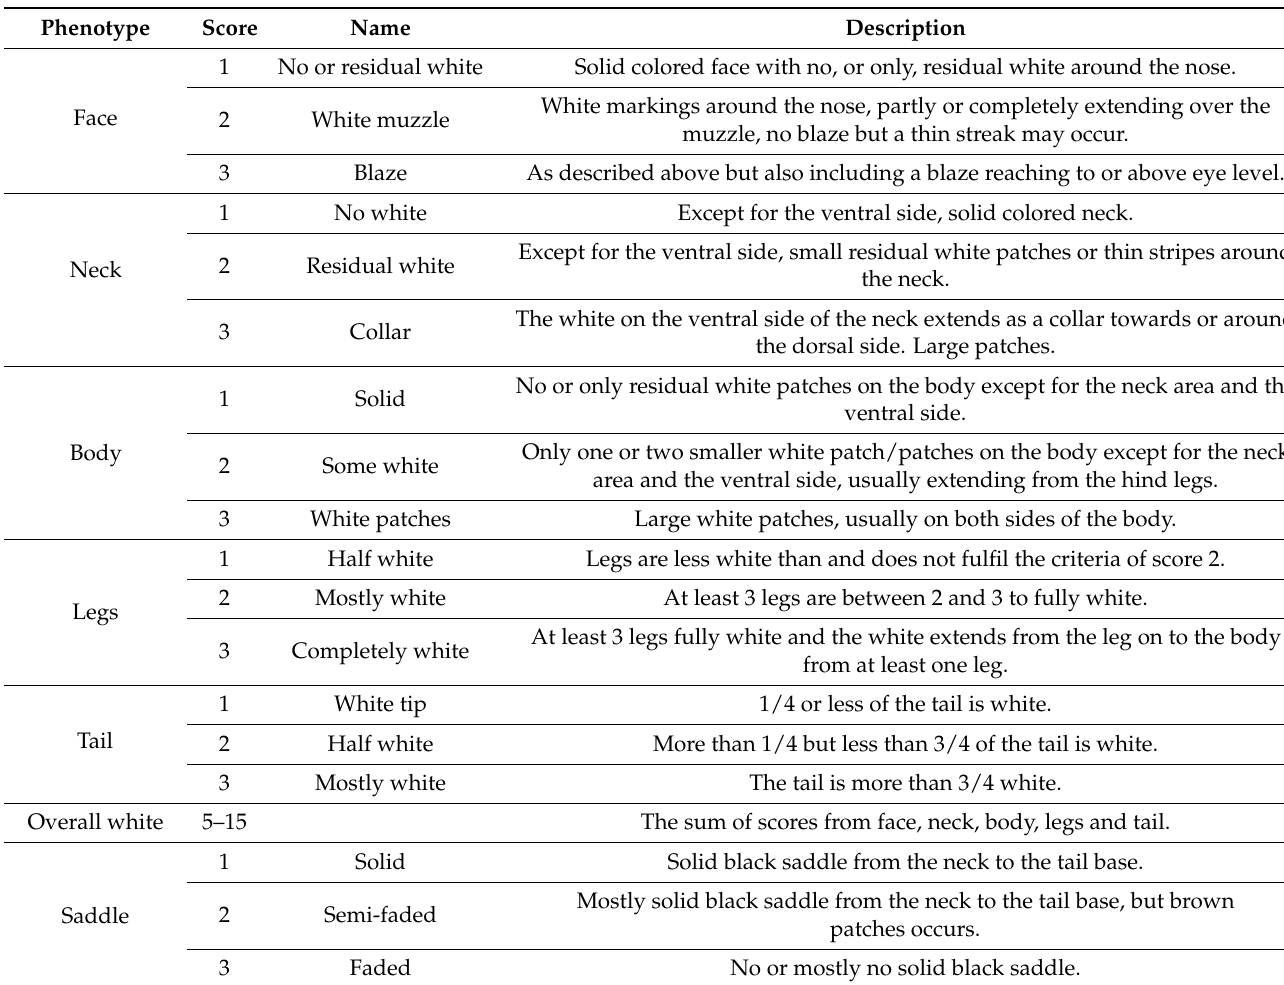
Table 1. Fur coloration scoring. A description of the scoring criteria for the different fur pigmentation phenotypes. Overall white is a combined score of all white patching